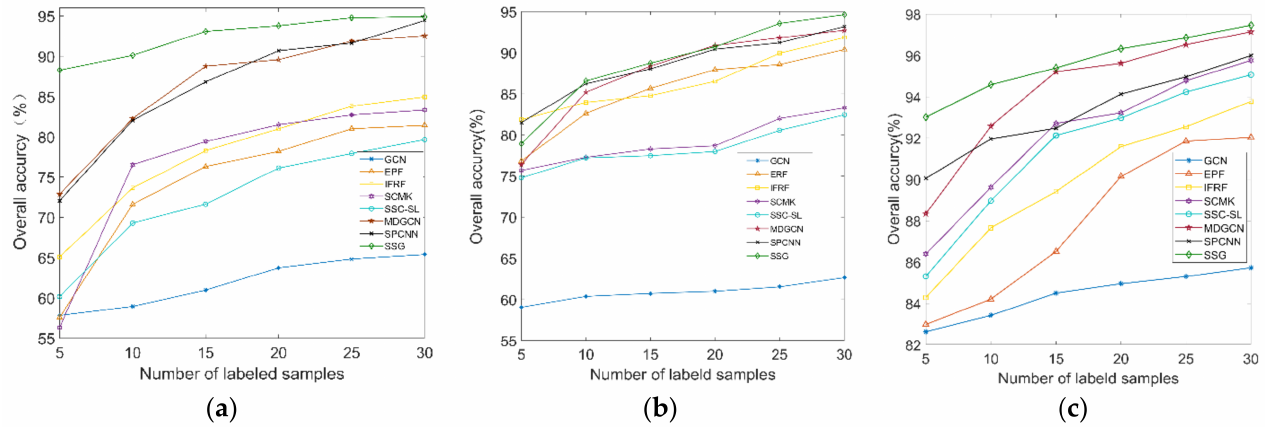
Figure 7. Change of classification accuracy on three images with the increase of the number of labeled pixels. ( a ) Indian Pines. ( b ) Pavia University. ( c ) Salinas.